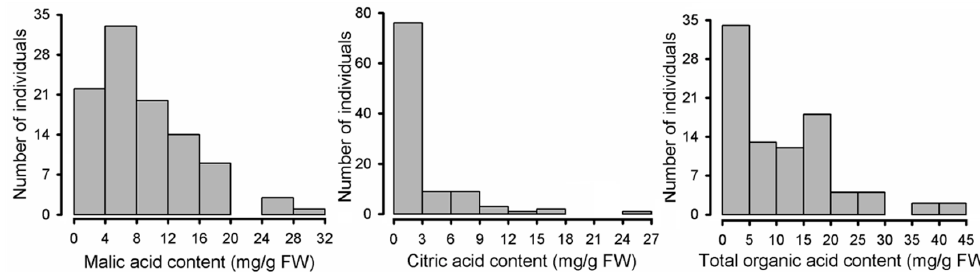
Figure 2. Distribution of organic acids measured for mature fruits of wild and cultivated apple.